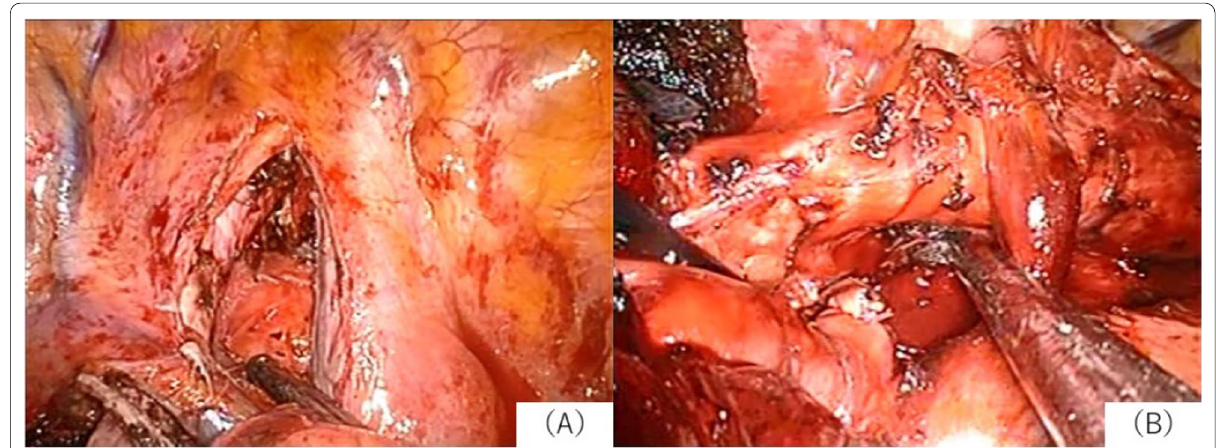
Fig. 1 Case 1: this figure shows the findings after the upper longitudinal node dissection. A is after the dissection of # 2R, and B is after the dissection of # 4R